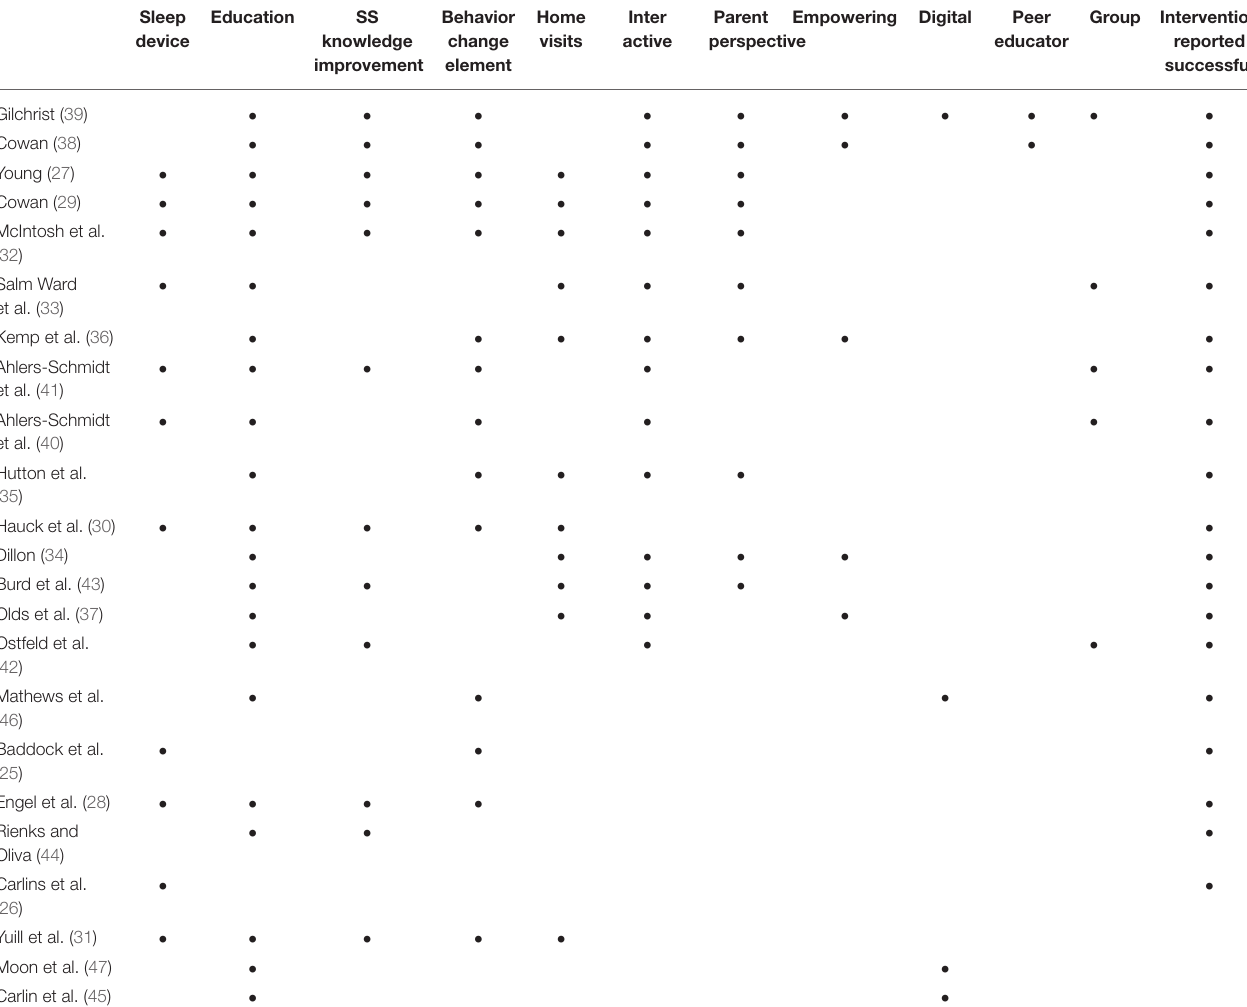
TABLE 2 | Intervention characteristics